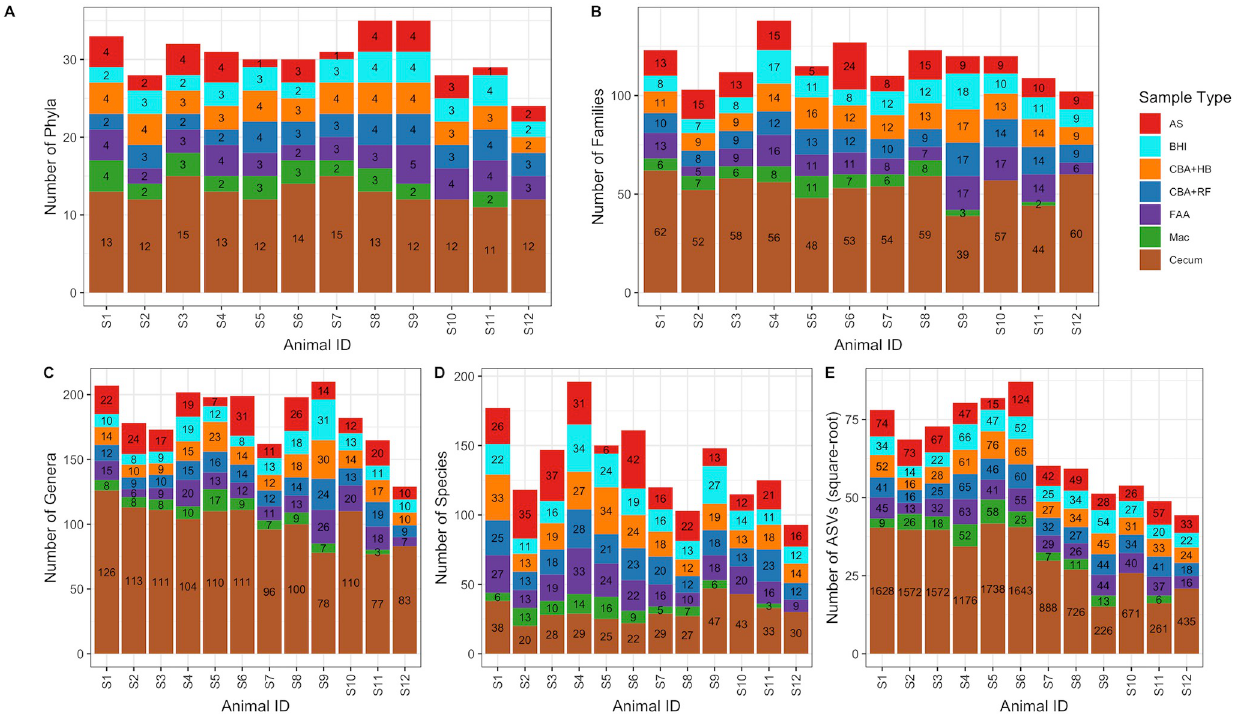
Fig 10. Number of bacterial taxa present in each sample type at multiple taxonomic ranks. The number of unique bacterial taxa are displayed for each sample type at A) phylum, B) family, C) genus, D) species, and E) ASV level. E) The y-axis is square-rooted for easier visualization of major differences between ASV counts between sample type. Unaltered number of ASVs are present within the stacked bars. Abbreviations: MacConkey agar (Mac), fastidious agar with horse’s blood added (FAA), Columbia agar with horse’s blood added (CBA+HB), Columbia agar with rumen fluid added (CBA+RF), BHI3 with carbohydrate added (BHI), AS (samples plated on CBA+HB after alcohol shock), and Cecum (samples sequenced directly, without culture). Healthy horses: S1-S6. Acute typhlocolitis horses: